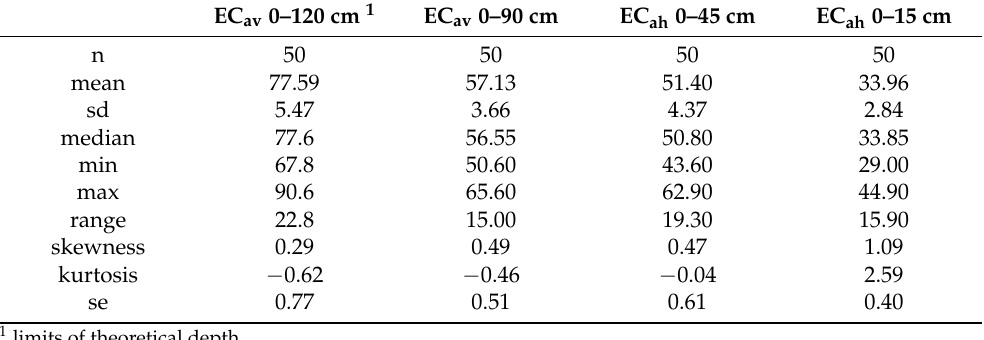
Table 2. Summary statistics of electrical conductivity values (EC a , mS/m), collected with EM38-mk at sampling sites.